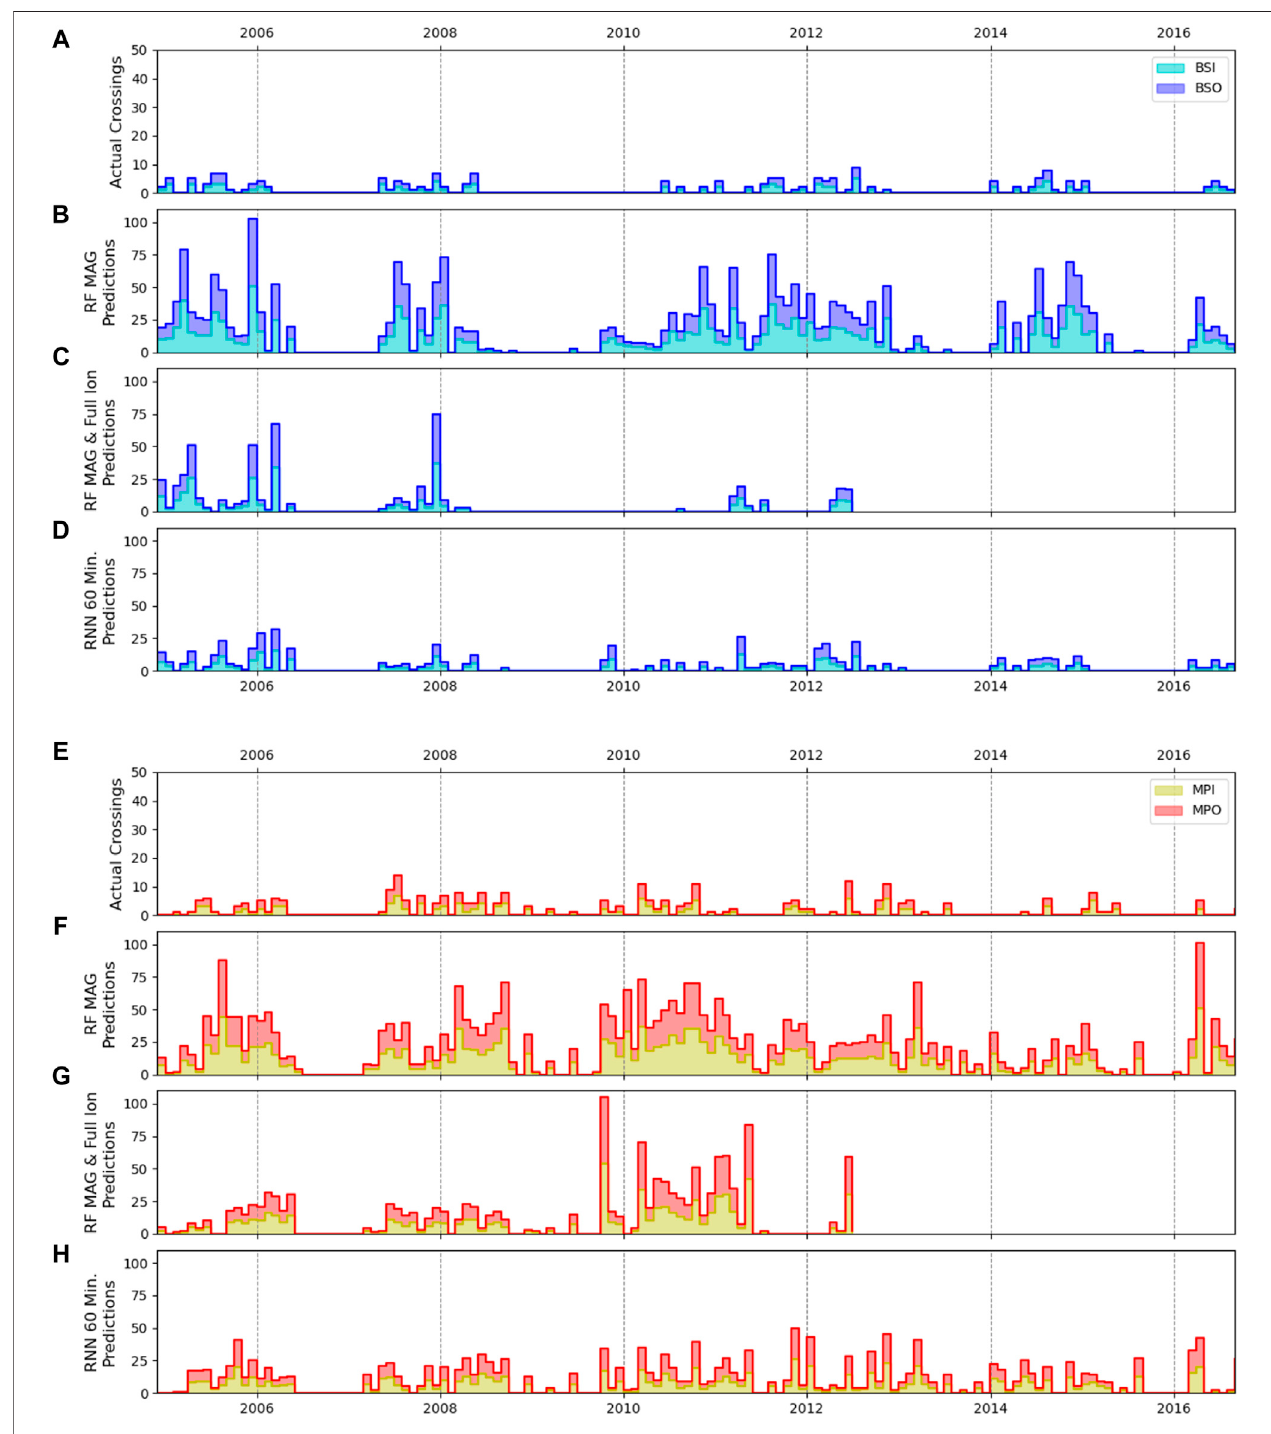
FIGURE9| Forthebowshocktransitions,comparisonofthenumbersofcrossingsfromthelabeleddataset (A) andthosepredictedbytheRFMAGmodel (B) ,RF MAG & full particle model (C) and RNN 60-min model (D) are shown in the top grouping of panels. The numbers of crossings were computed per each continuous segment of test data and grouped by month. Panels (E – H) show the corollary for the magnetopause crossings, with the number of actual magnetopause crossings shown in (E) . The number of actual crossings is then compared with predicted crossings from the RF MAG model (F) , RF MAG & full ion (G) and RNN 60-min models (H) . The vertical scaling of panels (A,E) are signi fi cantly smaller than the other panels to allow for ease of comparison. All models over-predict the number of crossings,however we fi ndofthethreeshownthattheRNN60-minmodelhasthebestperformance,withtheleastamountofcrossingspredicted andclosestcrossing type alignment to the true crossings shown in (A) and (E)